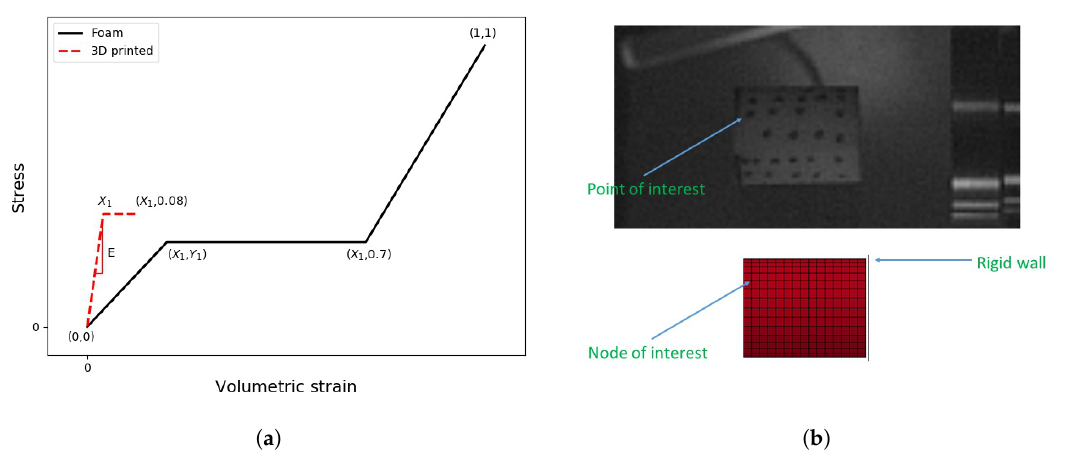
Figure 12. ( a ) Stress vs. volumetric strain of a virtual foam specimen; ( b ) definition of the points of interest for the experiment and the FE model.